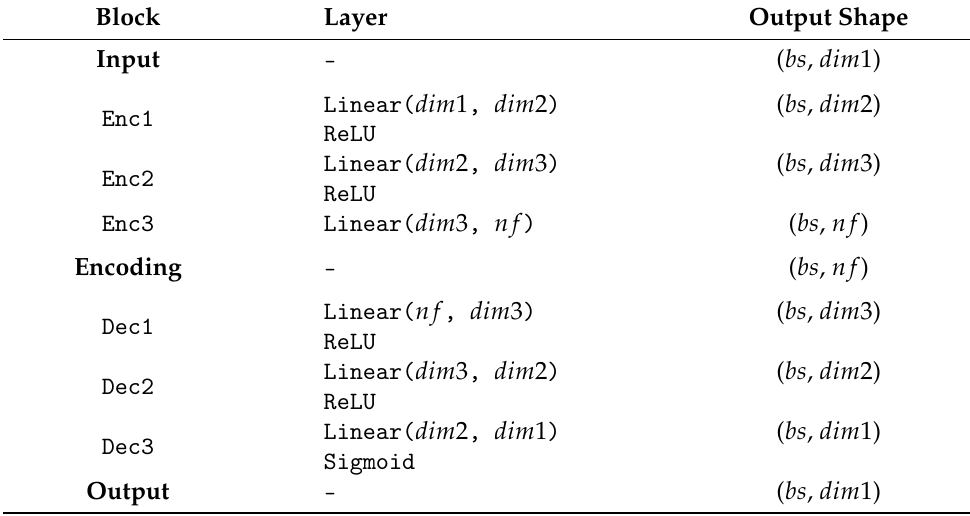
Table 2. Fully-Connected Autoencoder (FCAE)